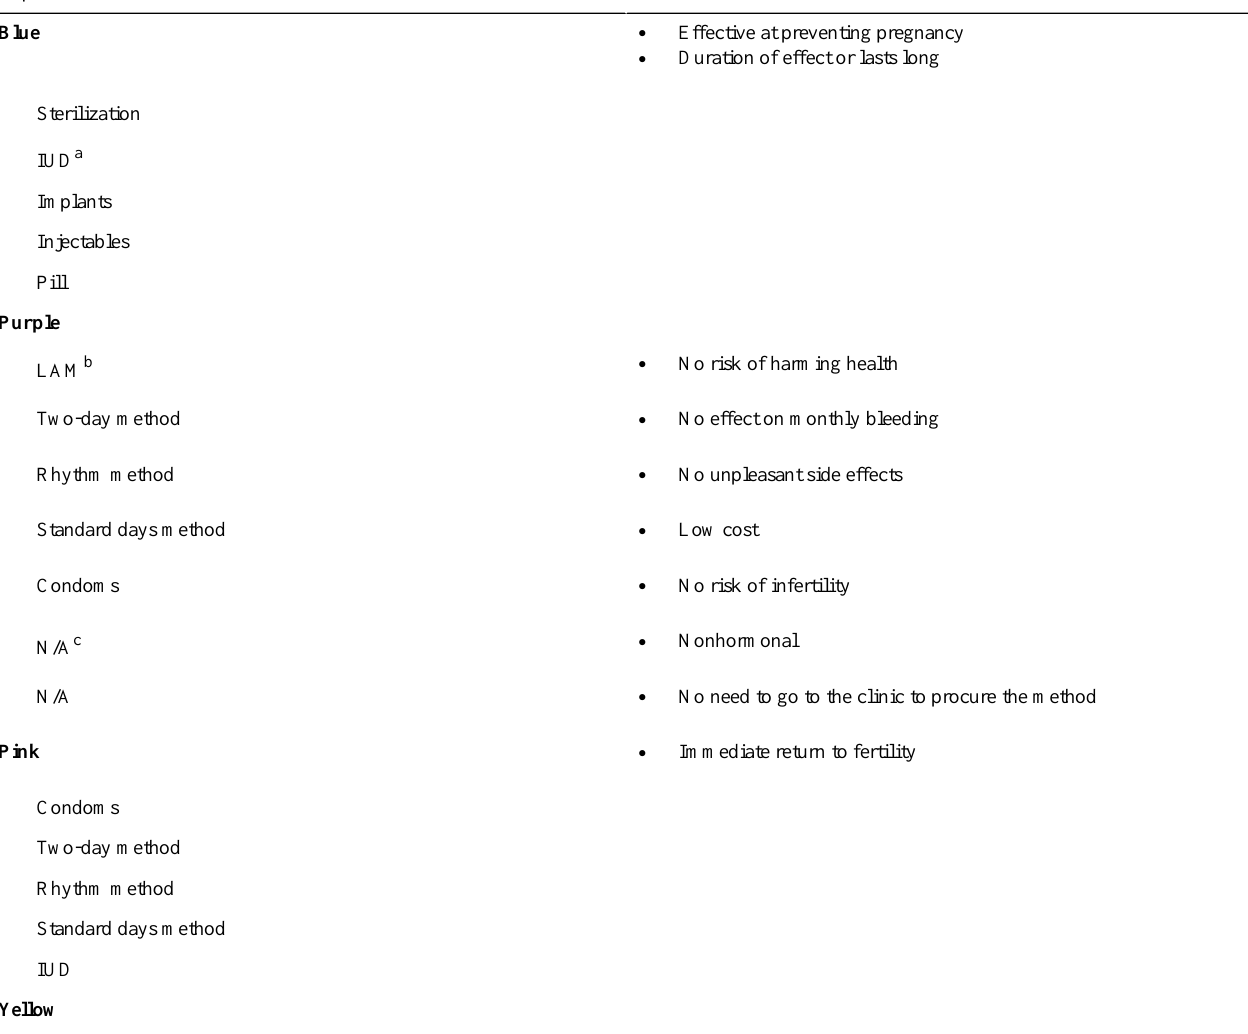
Table 2. Attribute-method flip chart correspondence. AttributesFlip chart color and